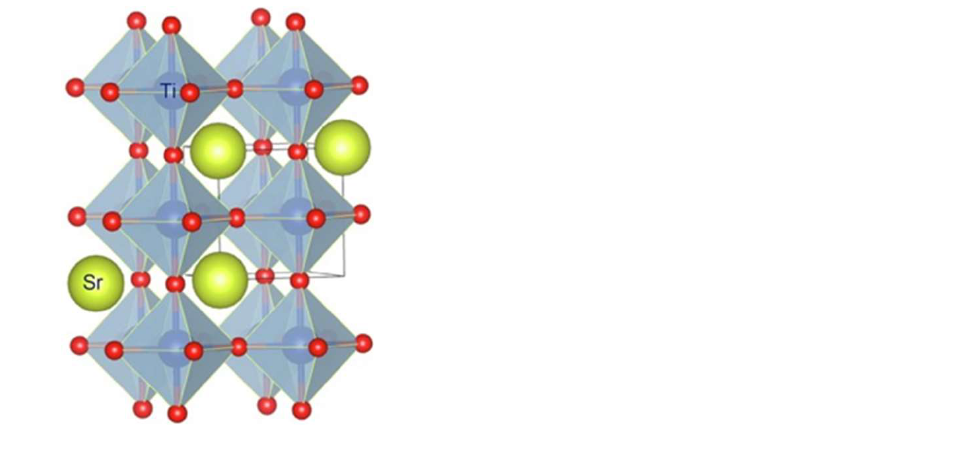
Figure 3. Structure of SrTiO 3 (cubic) [2]. Reprinted/adapted with permission from Elsevier, 2016.